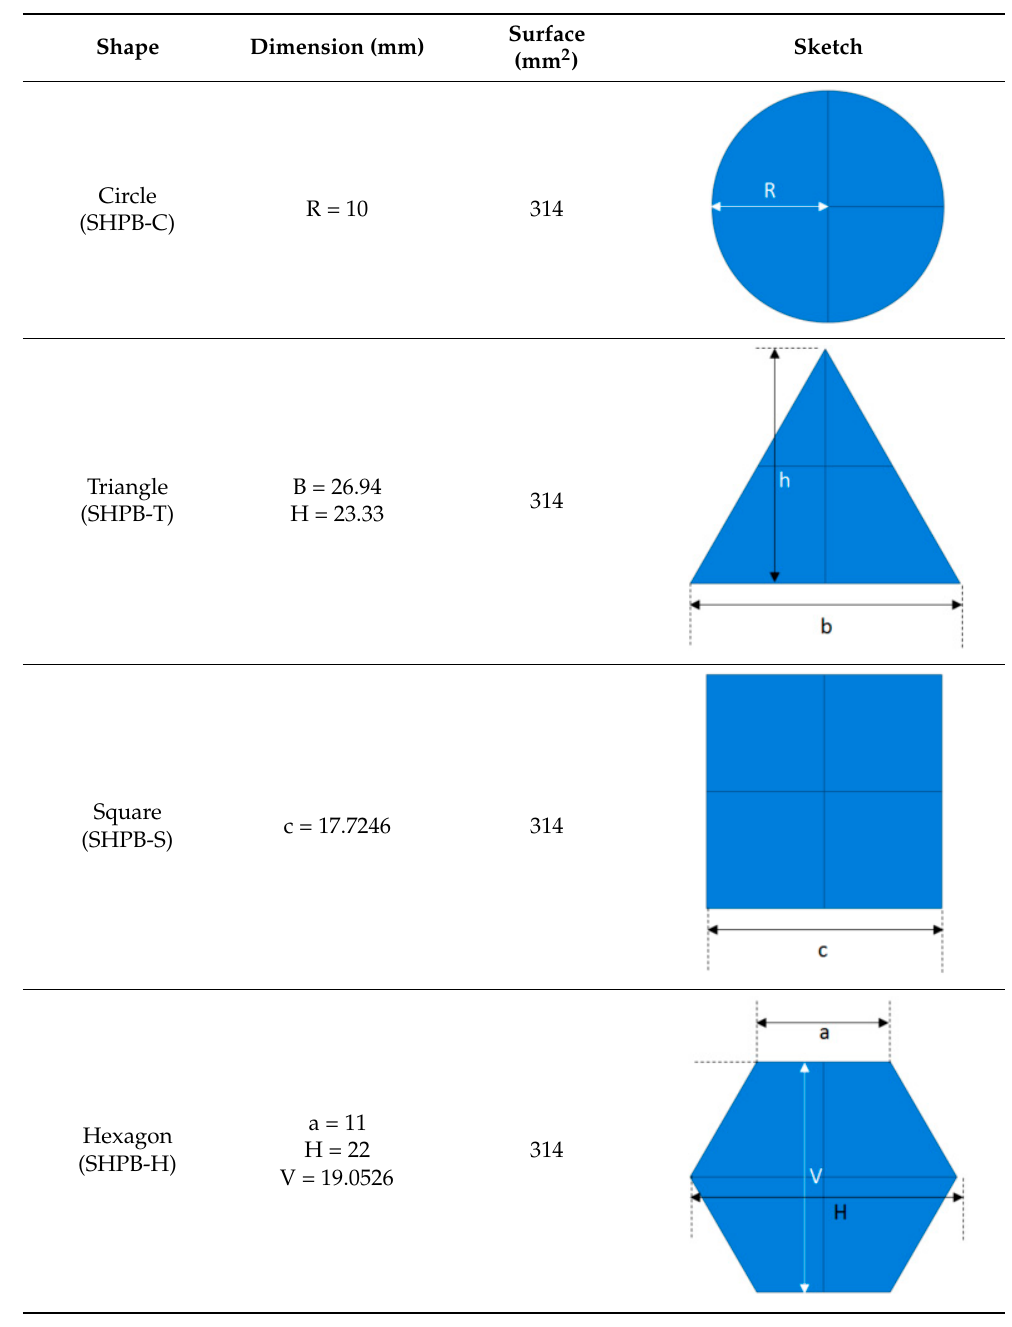
Table 3. Elastic properties of the bars and aluminium 6014-T4.